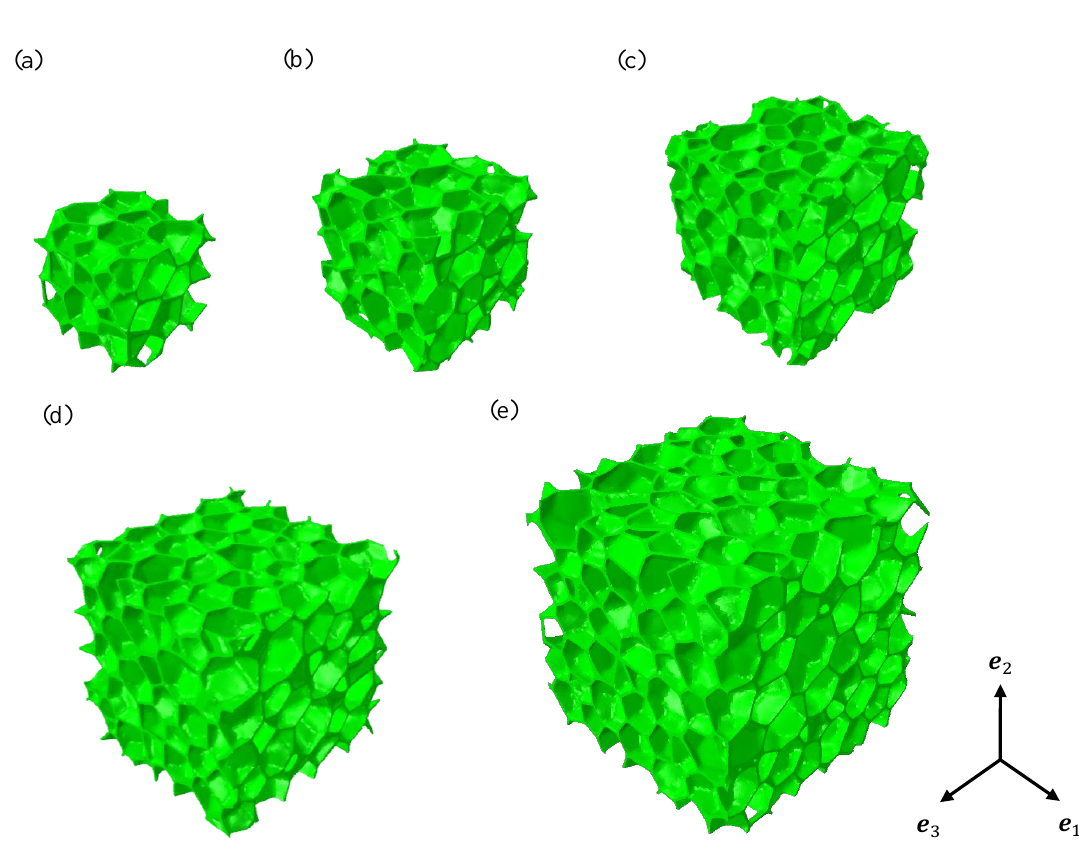
Figure 6. Illustration of the numerical irregular closed-cell model for ( a ) Set A; ( b ) Set B; ( c ) Set C; ( d ) Set D and ( e ) Set